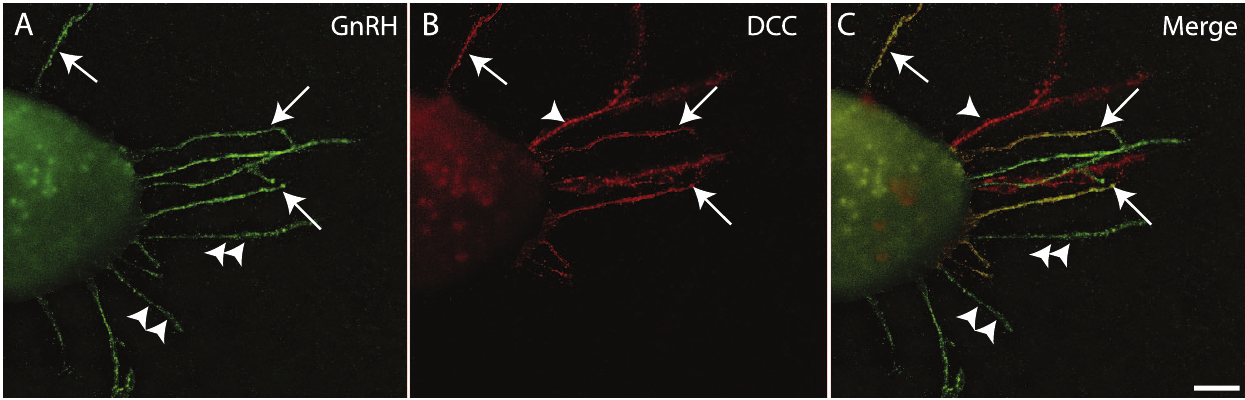
Figure 4. DCC is expressed by a subpopulation of GnRH neurites extending from POA explants invitro . Example images from dual-label immunocytochemistry to detect GnRH (green, left panel), DCC (red, middle panel), and two colors merged (right panel) performed on explants that had been grown for 2 DIV. Note that three different classes of neurites were visualized: GnRH + /DCC + (arrows), GnRH + /DCC - (double arrowheads), and GnRH 2 / DCC + (arrowheads). Scale bar, 20 m m.